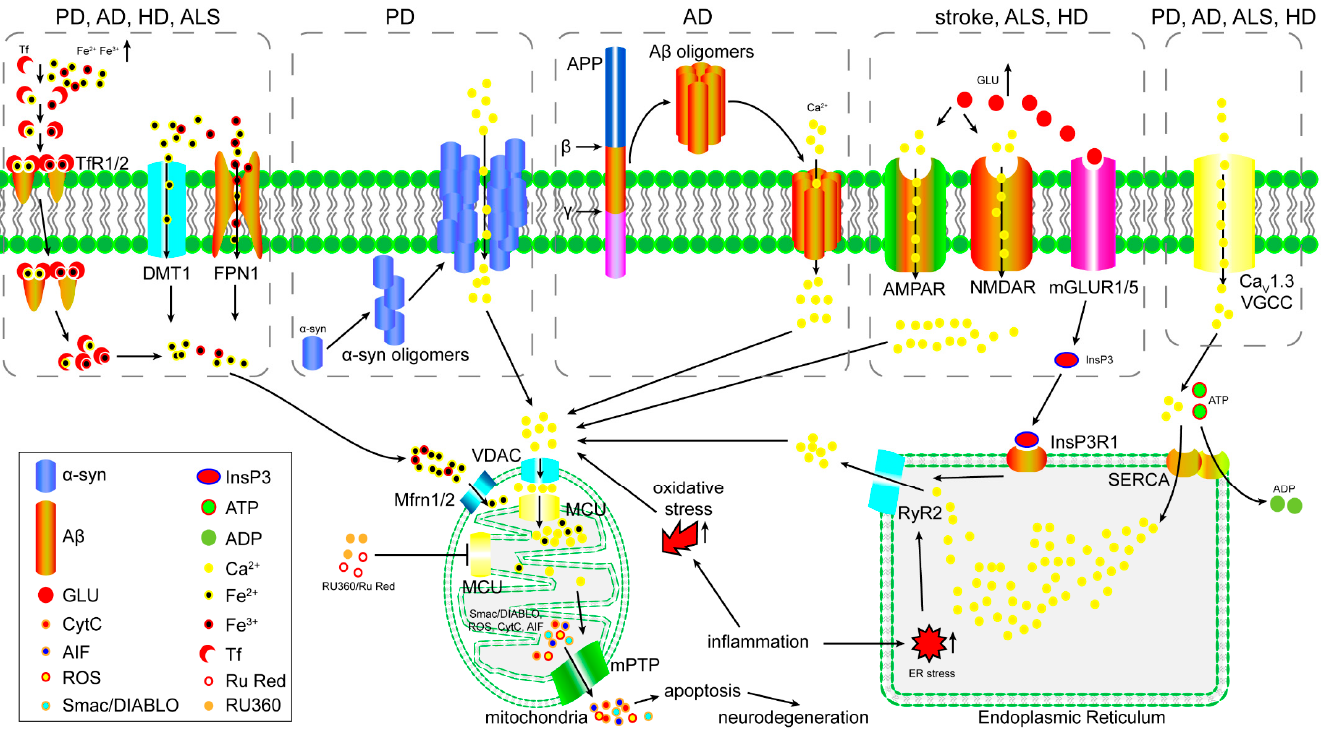
Figure 2. The proposed model of mitochondrial calcium dysregulation in neurodegenerative disorders and the potentiality of MCU as therapeutic target. Iron over-imported by TfR1/2, DMT1 and FPN1 will be taken up by mitochondria through Mfrn1/2 and potentially MCU. Excess calcium gets into cytoplasm through A β oligomers or α -syn oligomers formed ion channel, or glutamate receptors in pathological tissues of neurodegenerative disorders. InsP3R1 activation induce calcium release from ER. Continuous activation of L-type calcium channel Ca V 1.3 VGCC in PD, AD, HD and ALS. Excess calcium and iron in cytosol induce mitochondrial dysfunction, mPTP opening and pro-apoptosis factors release through MCU-mediated calcium and iron uptake. (PD: Parkinson’s disease; AD: Alzheimer’s disease; HD: Huntington’s disease; ALS: Amyotrophic lateral sclerosis; TfR1/2: transferrin receptor protein 1/2; DMT1: divalent cation transporter 1; FPN1: ferroportin-1; AMPAR: α -amino-3-hydroxy-5-methyl-4-isoxazolepropionic acid receptor; NMDAR: N-methyl-D-aspartate receptor; mGLUR1/5: metabotropic glutamate receptor 1/5; VGCC: voltage-dependent L-type calcium channel subunit β -2; VDAC: Voltage-dependent anion-selective channel; Mfrn1/2: mitoferrin 1/2: MCU: mitochondrial calcium uniporter; RyR2: ryanodine receptor 2; InsP3R1: inositol 1,4,5-trisphosphate receptor type 1; SERCA: Sarcoplasmic/endoplasmic reticulum calcium ATPase 2; GLU: glutamate; mPTP: mitochondrial permeability transition pore; CytC: cytochrome C; ROS: reactive oxygen species; AIF: apoptosis-inducing factor; Smac/DIABLO: Second mitochondria-derived activator of caspase/direct inhibitor of apoptosis-binding protein with low pI. ER: endoplasmic reticulum).